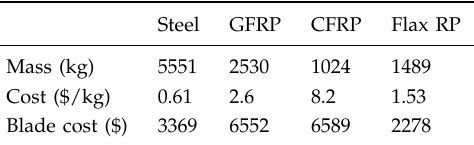
Fig. 8. Life cycle marine ecotoxicity impact for ten turbine blade material and treatment cases TABLE III M ATERIAL MASS AND RELATIVE COST ESTIMATE